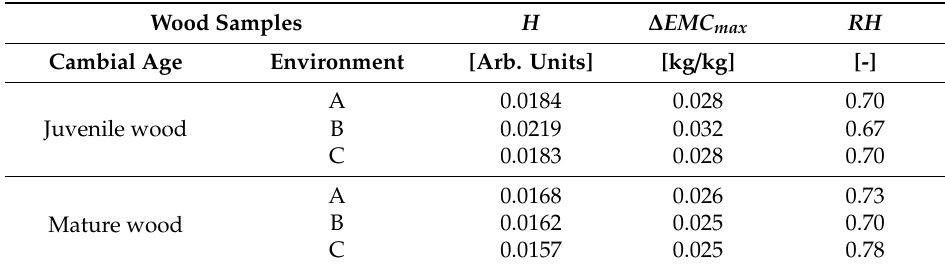
Figure 7. The sorption hysteresis ∆ EMC of the ( a ) juvenile and ( b ) mature lime ( Tilia cordata Mill.) wood at 20 °C taking into account growth conditions (A—forest, B—roadside, C—urban agglomeration). Table 8. Sorption hysteresis loop ( H ), maximum di ff erence in equilibrium moisture content for desorption and adsorption ( ∆ EMC max ) and corresponding air relative humidity ( RH ) indices for lime ( Tilia cordata Mill.)